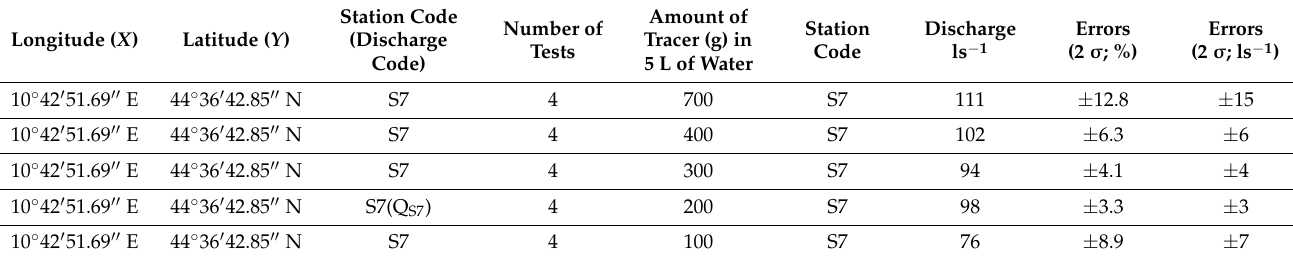
Table 1. Discharges (in ls − 1 along with the corresponding uncertainties equal to ± 2 σ ) as result of the salt injections tests carried out during campaign 1 at Station